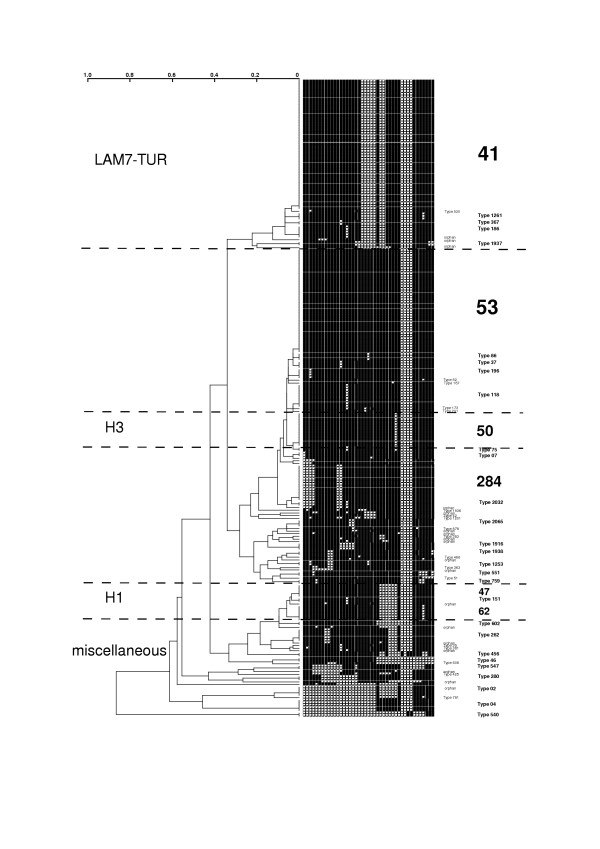
UPGMA tree constructed by numerical analysis of spoligotyping data using the Taxotron software (P.A.D. Grimont, Taxolab, Institut Pasteur, Paris). Remarkable genotypes are shown in bold at the extreme right of the picture (ST n°). The size of the characters is proportional to the frequency of genotypes. Dotted lines and some families (Haarlem1 and 3 as H1 and H3 and the newly "LAM7-TUR" family) are shown at the left of the dendrogram. Unique patterns are designated either as "orphan" or with their ST n° if already described in the SpolDB4 database.